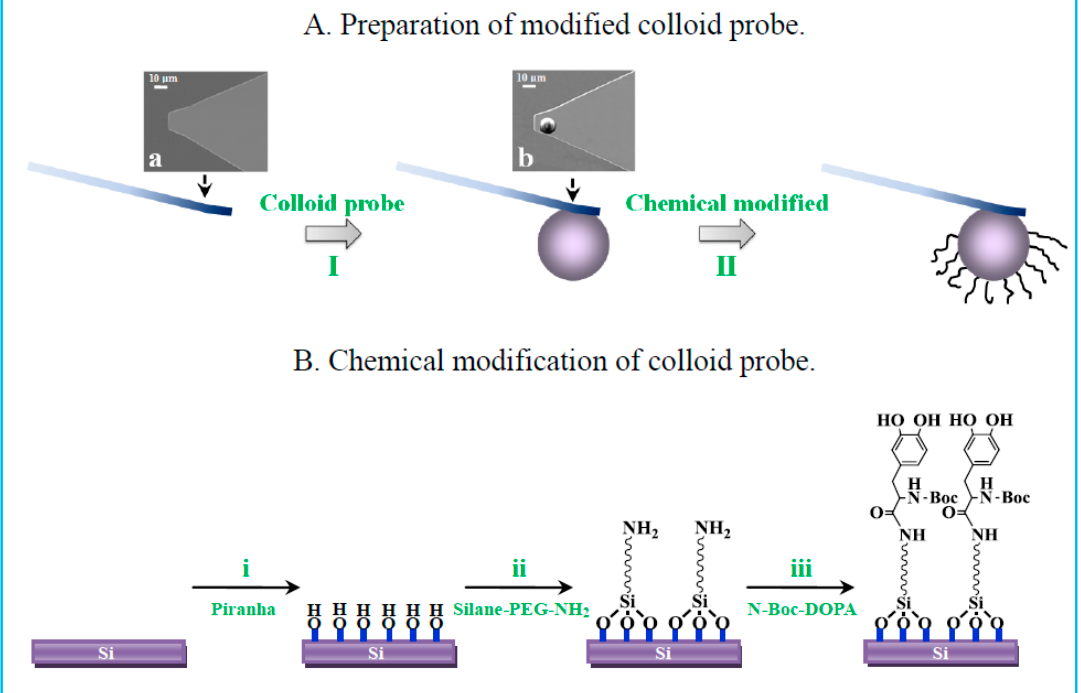
Figure 4. Schematic representation of chemical modification of colloidal atomic force microscopy (AFM) tip: A . Preparation of modified colloid probe: SEM images of ( a ) bare cantilever and ( b ) colloid probe; B . Chemical modification of colloid probe.